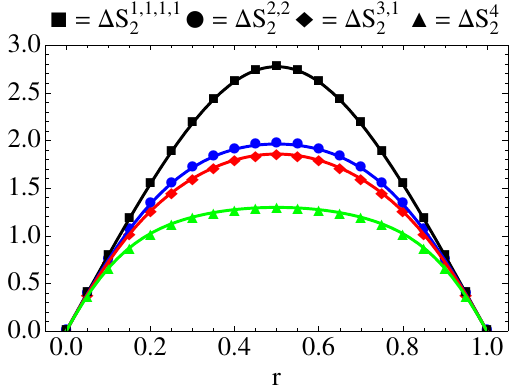
Figure 7 . 2nd R(cid:19)enyi entropies of four particle states for various choices of the momenta: P 1 (cid:25) 10, P 2 (cid:25) 20, P 3 (cid:25) 30, P 4 (cid:25) 40 (squares, black curve), P 1 = P 2 (cid:25) 30 ; P 3 = P 4 (cid:25) 50 (circles, blue curve), P 1 = P 2 = P 3 (cid:25) 30 ; P 4 = 50 (diamonds, red curve), and P 1 = P 2 = P 3 = P 4 (cid:25) 50 (triangles, green curve). In all cases m = 1 ; L = 10 and (cid:1) x = 0 : 01. Agreement with analytic expressions is